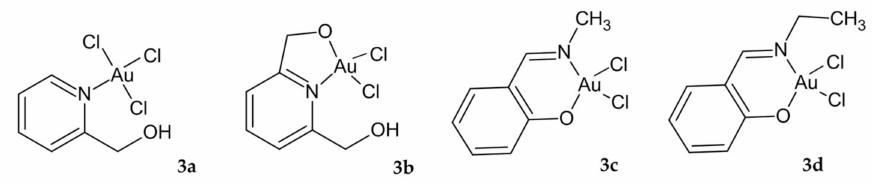
Figure 2. Au complexes 3a – d with a square-planar geometry. Table 2. Characterization of the anticancer properties of new organogold